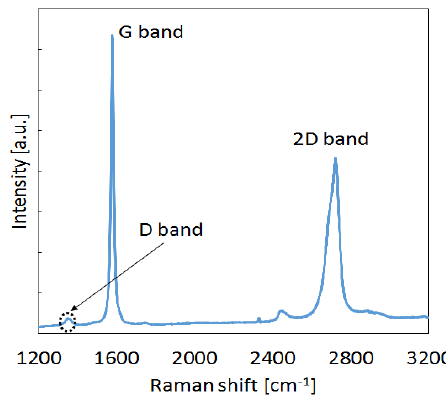
Figure 2. Raman spectrum of the commercial GNPs.